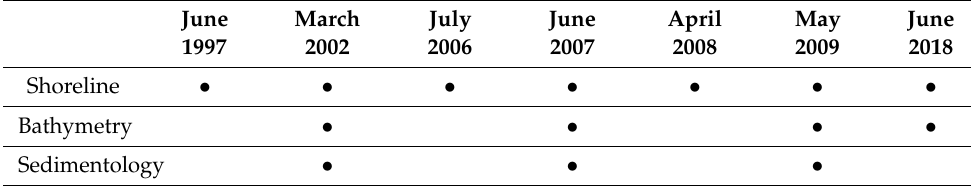
Table 1. Available data concerning Cavo beach